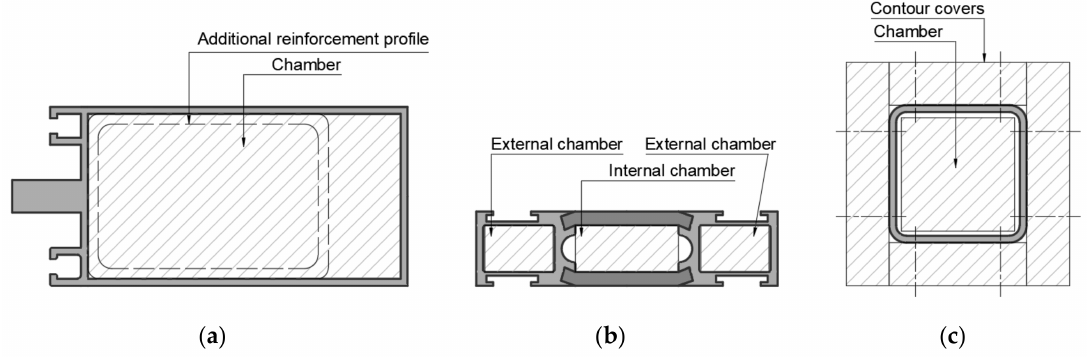
Figure 1. Example of fire protection infills and contour covers: ( a ) Façade profile; ( b ) thermal break window / door / partition profile; ( c ) construction hollow